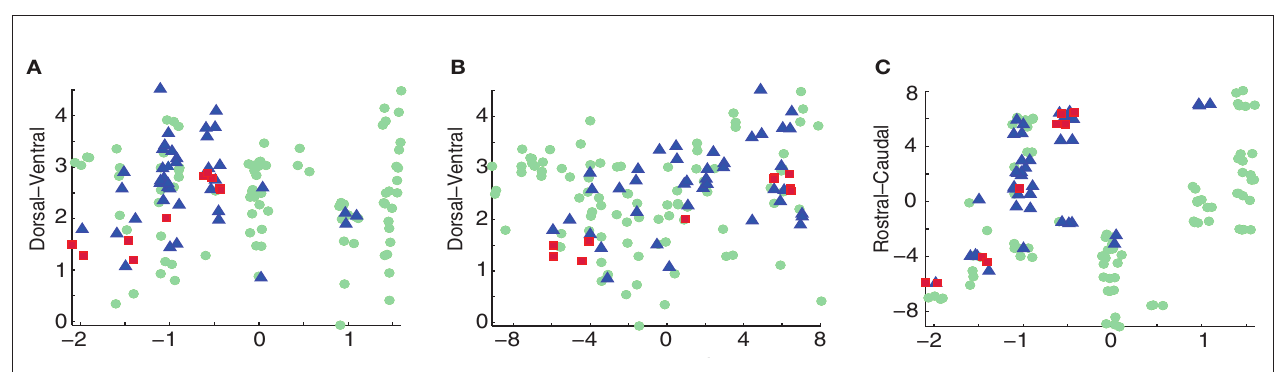
FigUre A2 | Untransformed version for the K-means method in Monkey V. See Figure 2 for further